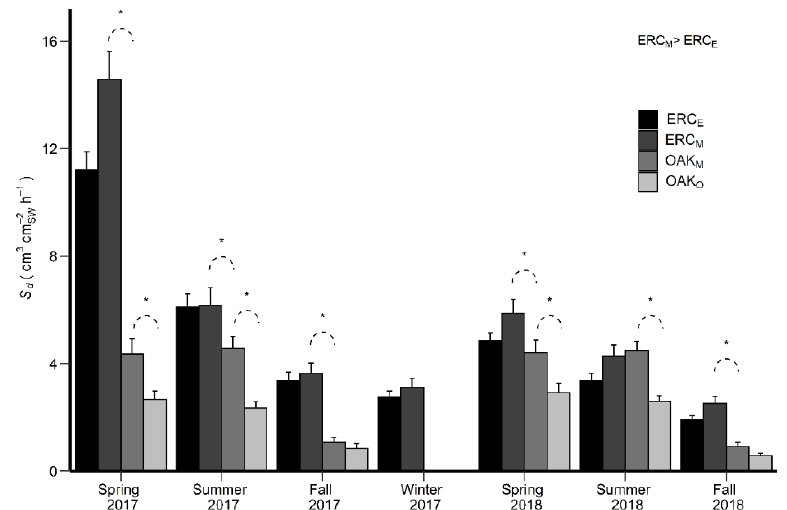
Figure 3. Seasonal averages of sap flow density ( S d ) for eastern redcedar in the pure stand (ERC E ), eastern redcedar in the mixed stand (ERC M ), post oak in the mixed stand (OAK M ), and post oak in the pure stand (OAK O ). The S d data for the spring of 2017 cover from 15 May to 31 May. The later growing season for oak covers from 1 September to 5 November for both years. An asterisk (*) indicates significant di ff erences ( p < 0.05) within a season when there was a season × stand interaction. The dashed half circle indicates the comparison among treatments referenced by the asterisk. Vertical bars denote standard